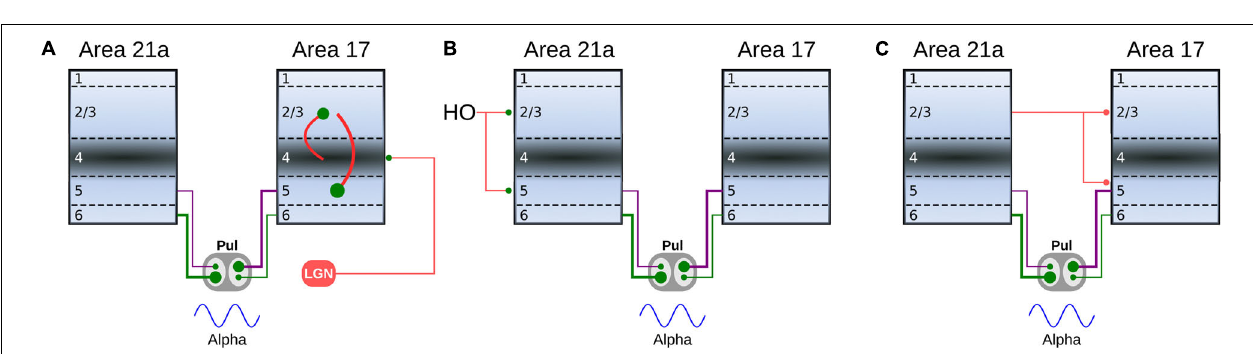
FIGURE 13 | Schematic representation of the oscillatory responses predicted by our models. (A) The pulvinar evokes an alpha-band oscillatory response by the feedforward activity of area 17. The response of the infragranular layers of area 17 is evoked by the inter-laminar connectivity that initially reaches layer 4. (B) Oscillatory alpha-band responses in the pulvinar are evoked by feedback activity from higher order (HO) cortical areas to the infragranular layers of area 21a. (C) Indirect oscillatory alpha-band activation of the pulvinar by the feedback from area 21a to the infragranular layers of area 17.